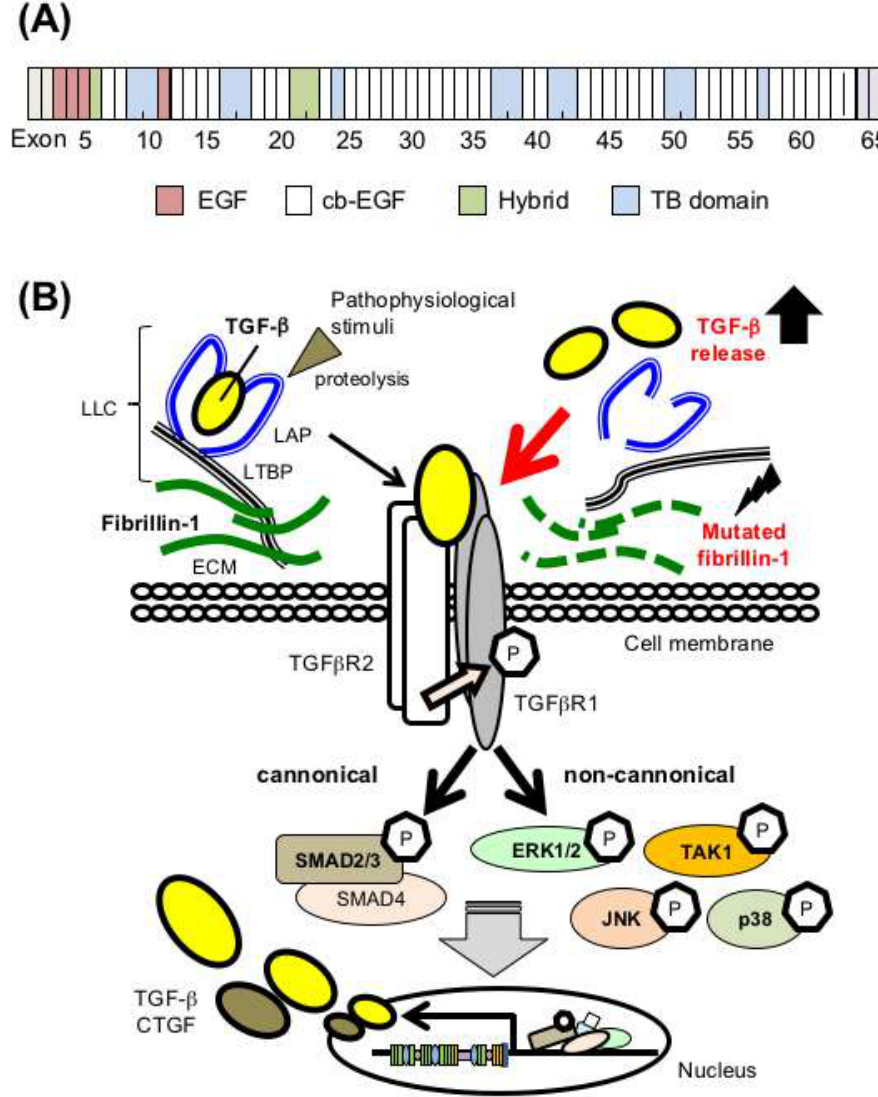
Figure 1. Mutations in the FBN1 gene encoding fibrillin-1 cause dysregulation of TGF-β bioavailability in Marfan syndrome ( MFS). ( A ) Domain structure of fibrillin-1. EGF, epidermal growth factor-like domains; cb-EGF, EGF-like domains with a calcium binding domain; TB, TGF- β binding protein-like domains; Hybrid, hybrid domain containing features of both TB and cb-EGF domains. ( B ) (left side) TGF-β is secreted in an inactivated latent form that requires proteolysis for activation. (right side) Mutated fibrillin-1 in MFS leads to failed sequestration of latent TGF-β in the ECM and subsequent activation of canonical and noncanonical TGF-β signaling cascades, which would play critical roles in MFS pathogenesis. ‘P’ indicates phosphorylation. LLC, large latent complexes; LAP, latency-associated peptide; LTBP, latent TGF-β binding protein; CTGF, connective tissue growth factor.